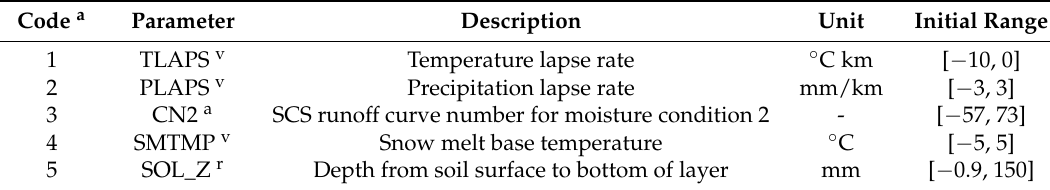
Table 2. Parameters used in SWAT model, and their ranges used in